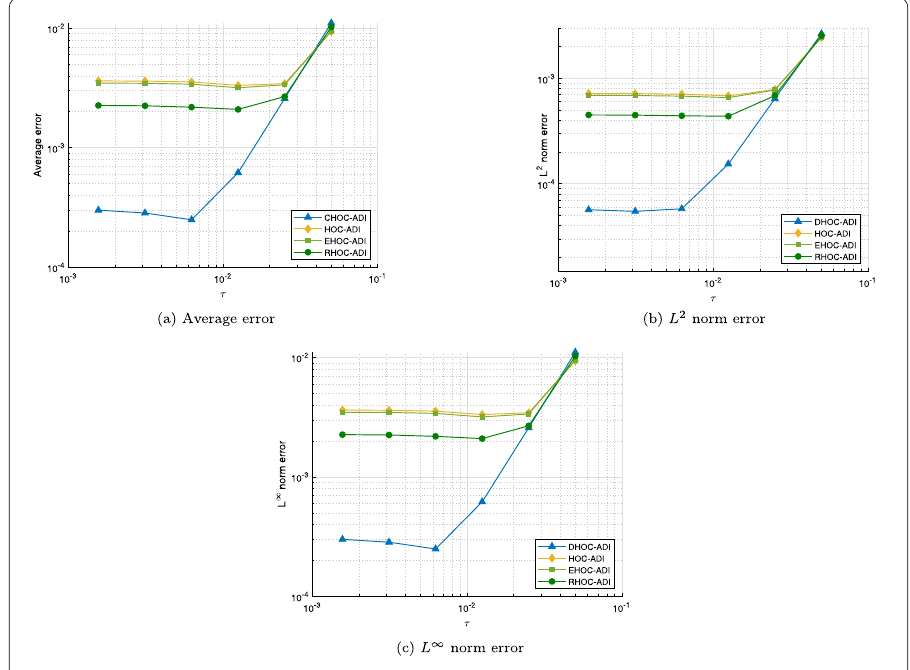
Figure 4 The errors of numerical solutions using h x = h y = 0.05 under different temporal step sizes